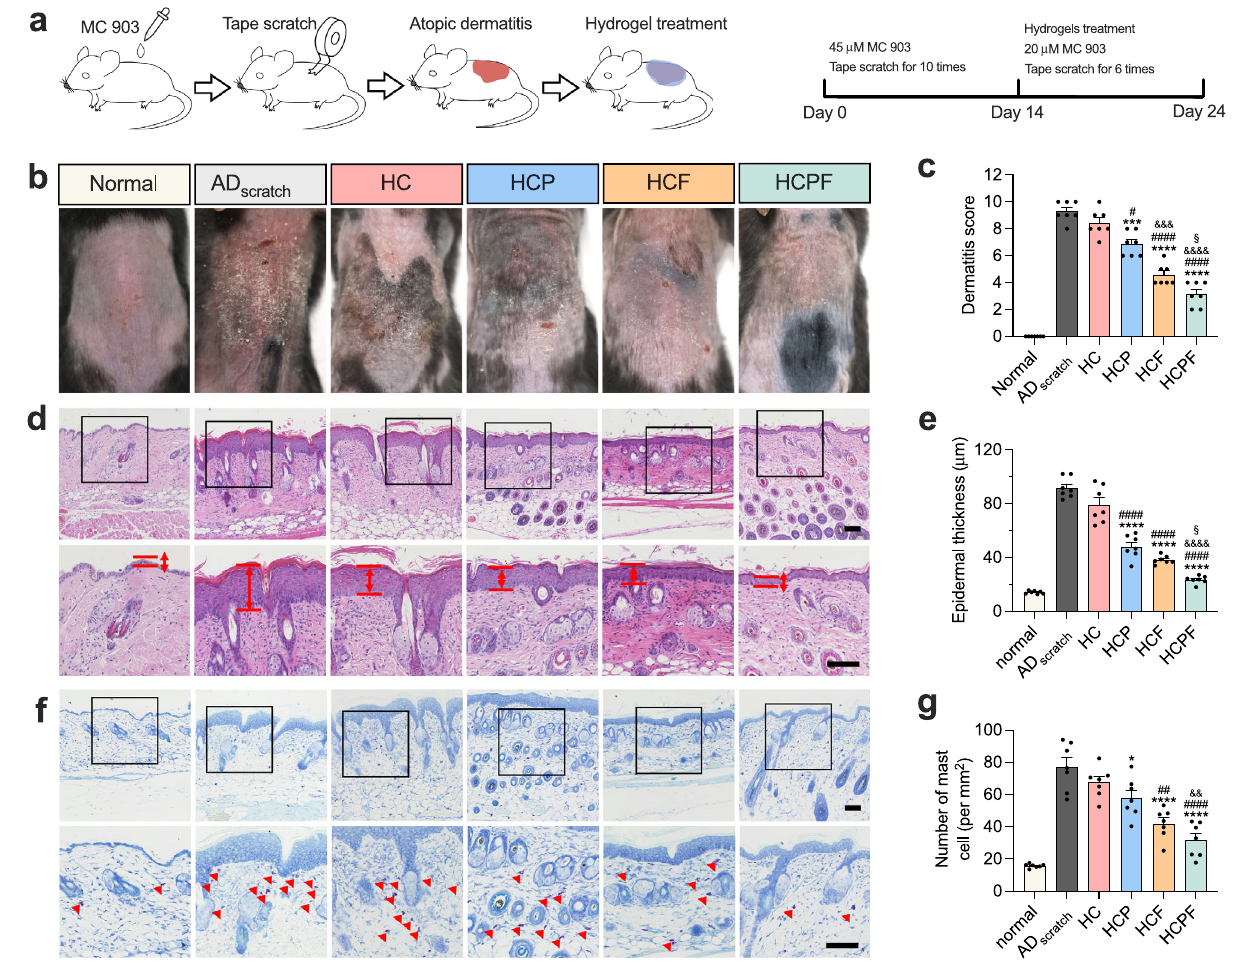
Fig. 6 | HCPF hydrogels reduce lesions and mast cell in fi ltration in mice AD skins. a Schematic diagram of animal experiments. b Representative photographs of the dorsal skin of each group on day 24. c Dermatitis score of each group assessed from photographs in ( b ). d Representative H&E staining of skin section. The black boxed area is enlarged below. The space between red lines denotes the epidermalthickness.Scalebar,100 μ m. e Epidermalthicknessquanti fi edfromH&E staining. f Representative toluidine blue staining of skin section. The red triangle